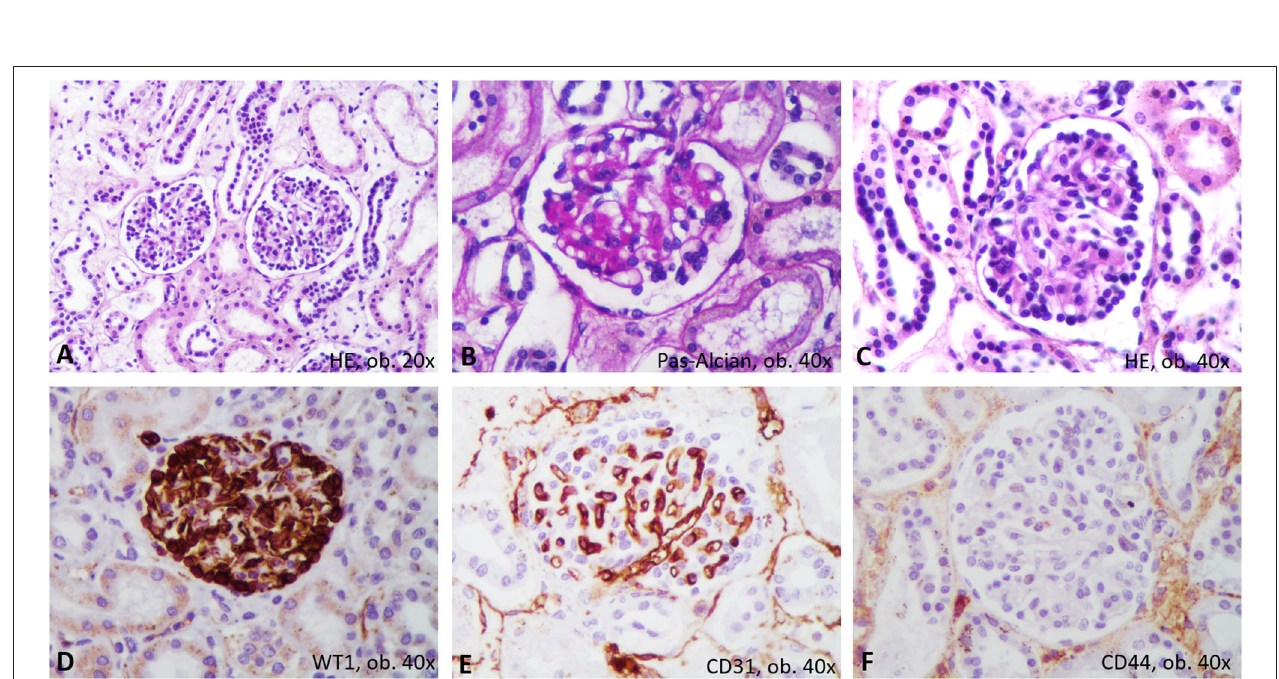
FIGURE 6 | Proliferative glomerulonephritis. In Hematoxylin-Eosin, microscopic features consist on mesangium enlargement and proliferation of podocytes (A–C) . Immunohistochemically, the proliferated podocytes are marked by WT1 (D) and surround the CD31-positive capillaries (E) , without positivity for CD44 (F) .